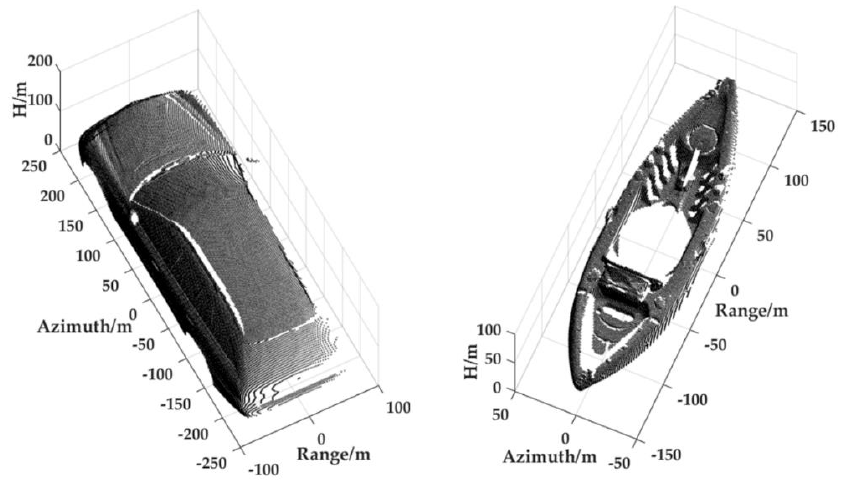
Figure 13. Car body lattices ( left ) and assault boat lattices ( right ).